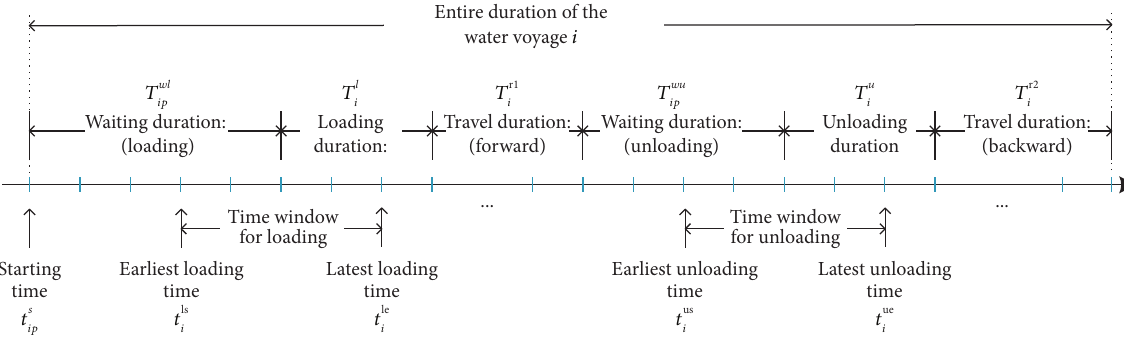
Figure 2: Relationship between the definitions of the water voyage time